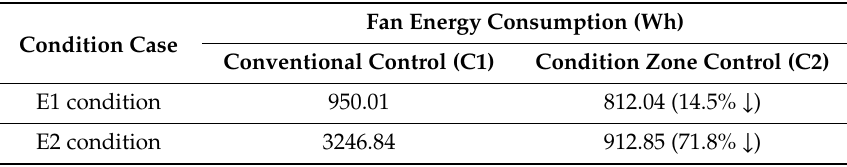
Table 8. Comparison of fan energy consumption during E1 condition and E2